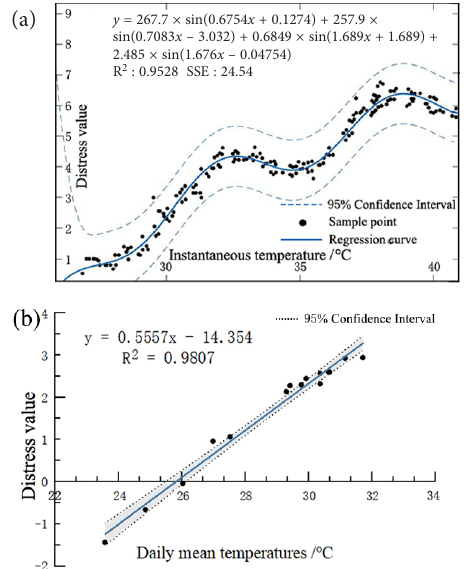
anxiousFigure 3. Analysis of the relationship between temperature and distress: a) Theoretical relationship between transient temperature and distress; b) Relation curve between daily mean temperature and distress